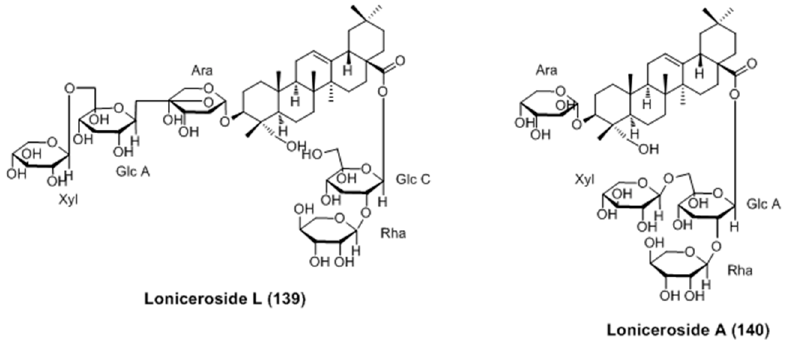
Figure 26. Structure of triterpene glycosides isolated from aerial parts of Weigela subsessilis .